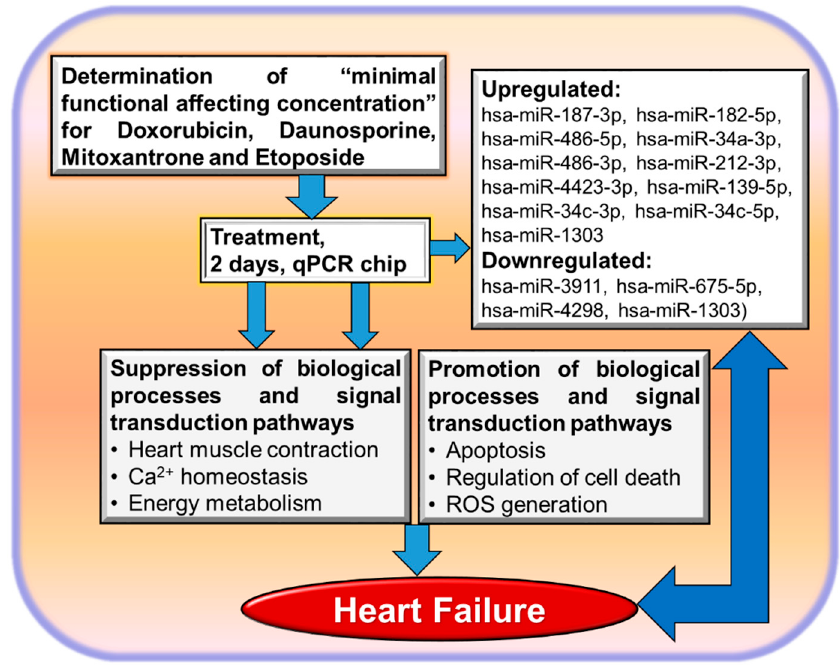
Figure 3. Common pathways of anticancer drug-induced cardiotoxicity, as well as microRNA biomarkers, which are relevant for the development of heart failure. Pathways were identified applying the in vitro cardiotoxicity system as shown in Figures 1 and 2. As determined from in vivo animal studies [23,24] , anthracyclines and ETP elicit cardiotoxic effects via reactive oxygen species (ROS)-induced apoptosis, mitochondria damage, and inflammation (upregulation of growth differentiation factor 15 (GDF15)) in hCMs [37–39,41] .